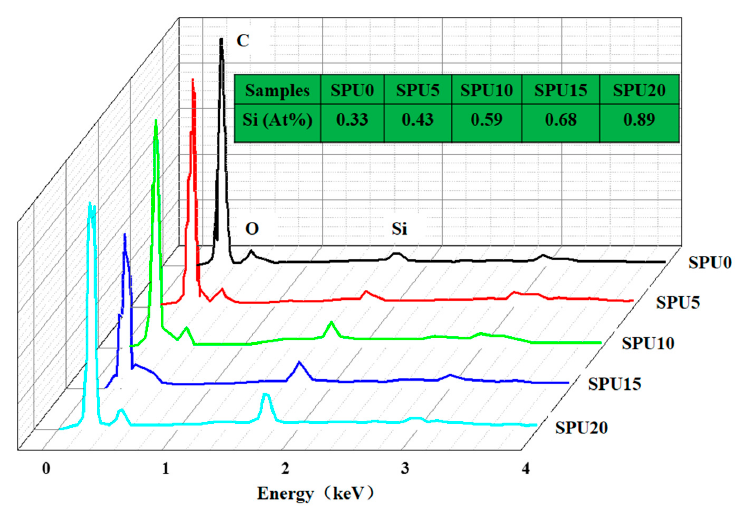
Figure 11. EDS analysis of different SPU films surfaces.